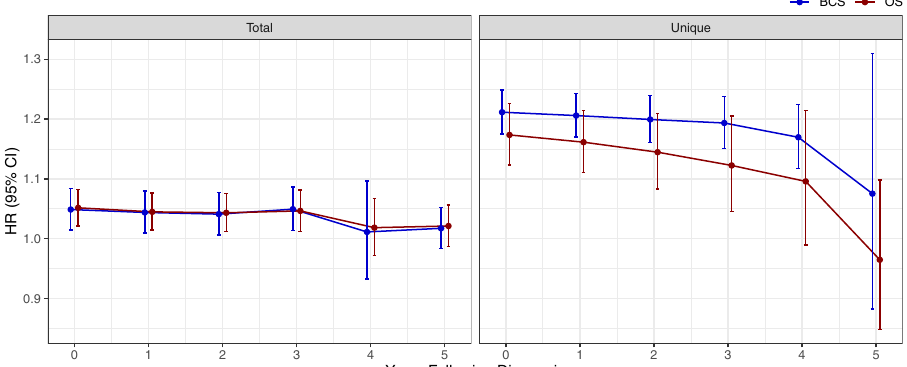
Fig.3|Landmarkinganalysistoevaluatetheimpactofantimicrobialexposure on survival over time on N =772 independent patients. Data were presented as the hazard ratios±95% con fi dence intervals that re fl ect the risk of ongoing anti- microbial exposure at yearly intervals post-diagnosis and are plotted for the